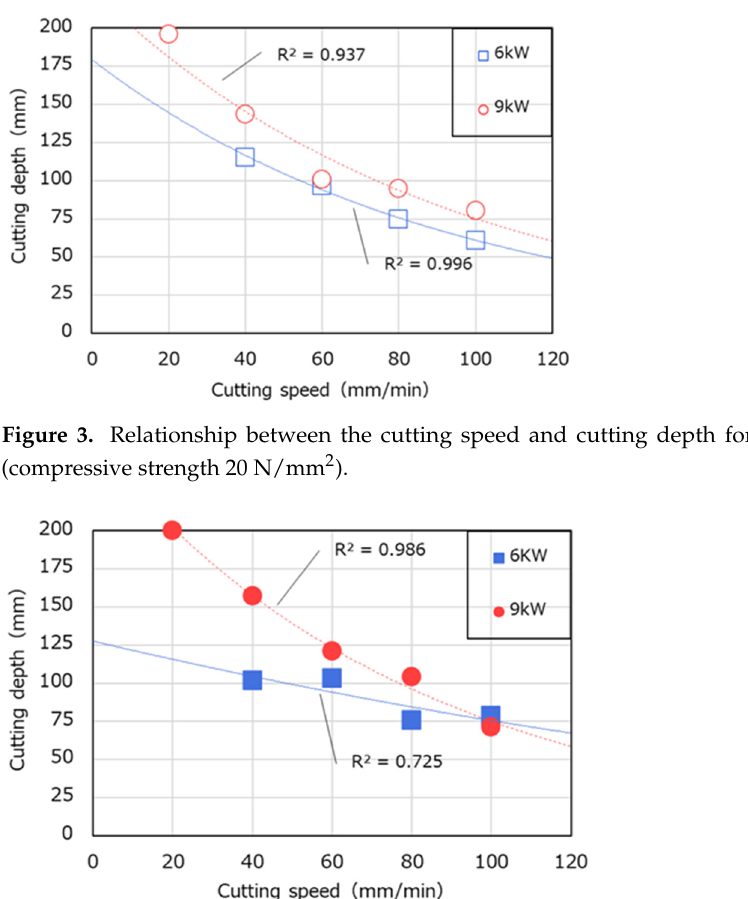
Figure 5. Correlation between cutting depth and concrete strength (laser 6 kW).